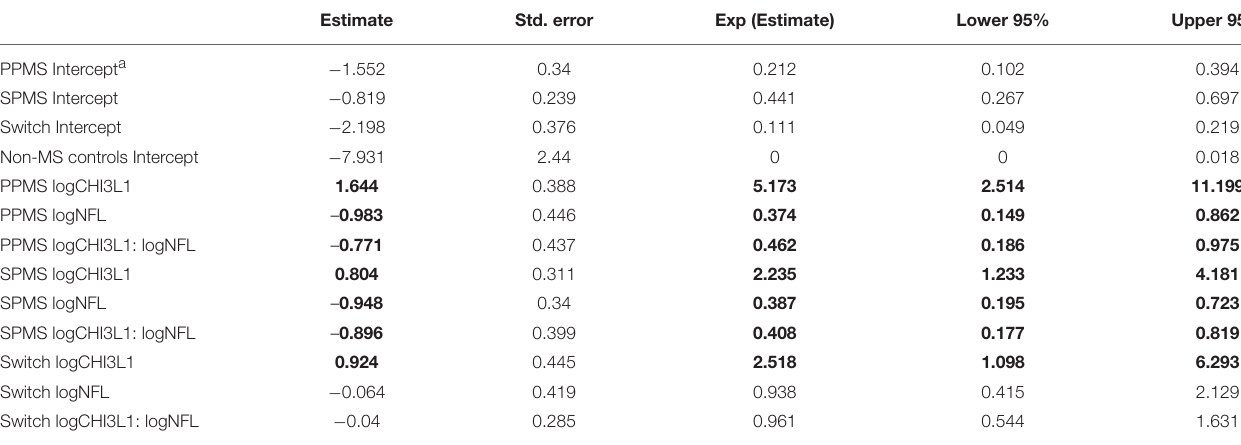
Estimate Std. error Exp (Estimate) Lower 95% Upper